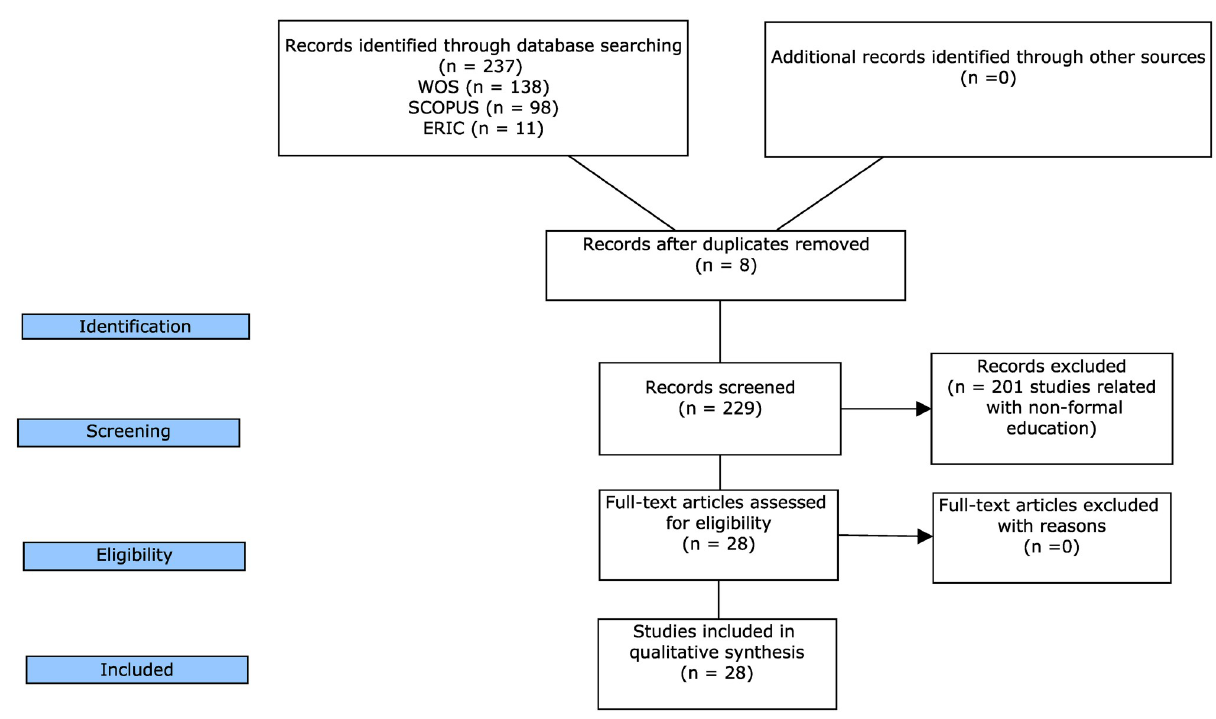
Fig 1. PRISMA flowchart. Modified from Moher, et al. (2009) [44].